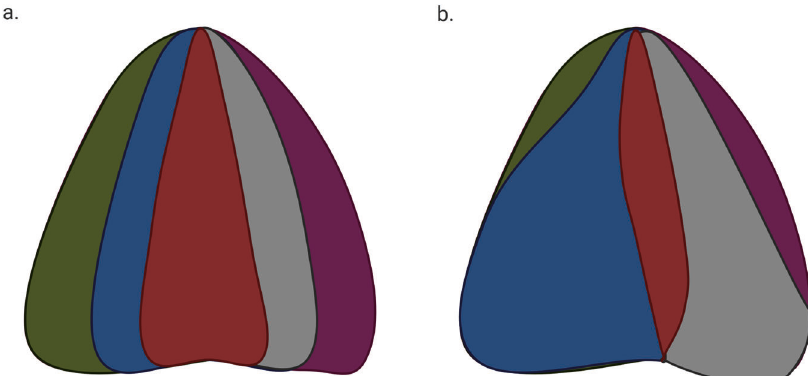
Fig. 2 Two different evolutionary models are presented here, with each colour representing a subclonal population. In ( a ) the big bang model, multiple subclonal populations are seen early and followed by a period of neutral evolution. In ( b ) the Darwinian model, subclones with a selective advantage outgrow other